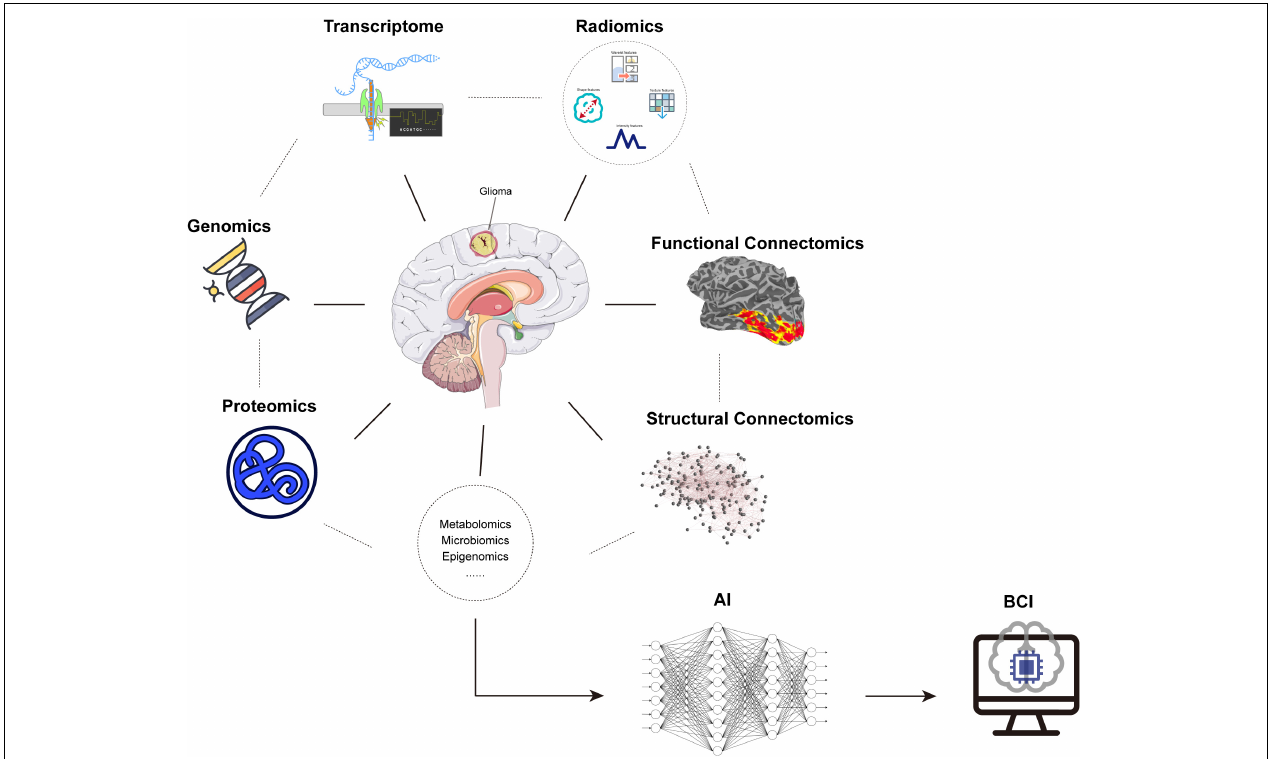
FIGURE 2 | Glioma-related multi-omics. Combination of omics including genomics, transcriptome, proteomics, radiomics, connectomics, etc. from microscopy to macroscopy and application of AI provided a novel and detailed approach for glioma, accompanied by a potential for BCI. AI: artificial intelligence, BCI: brain–computer